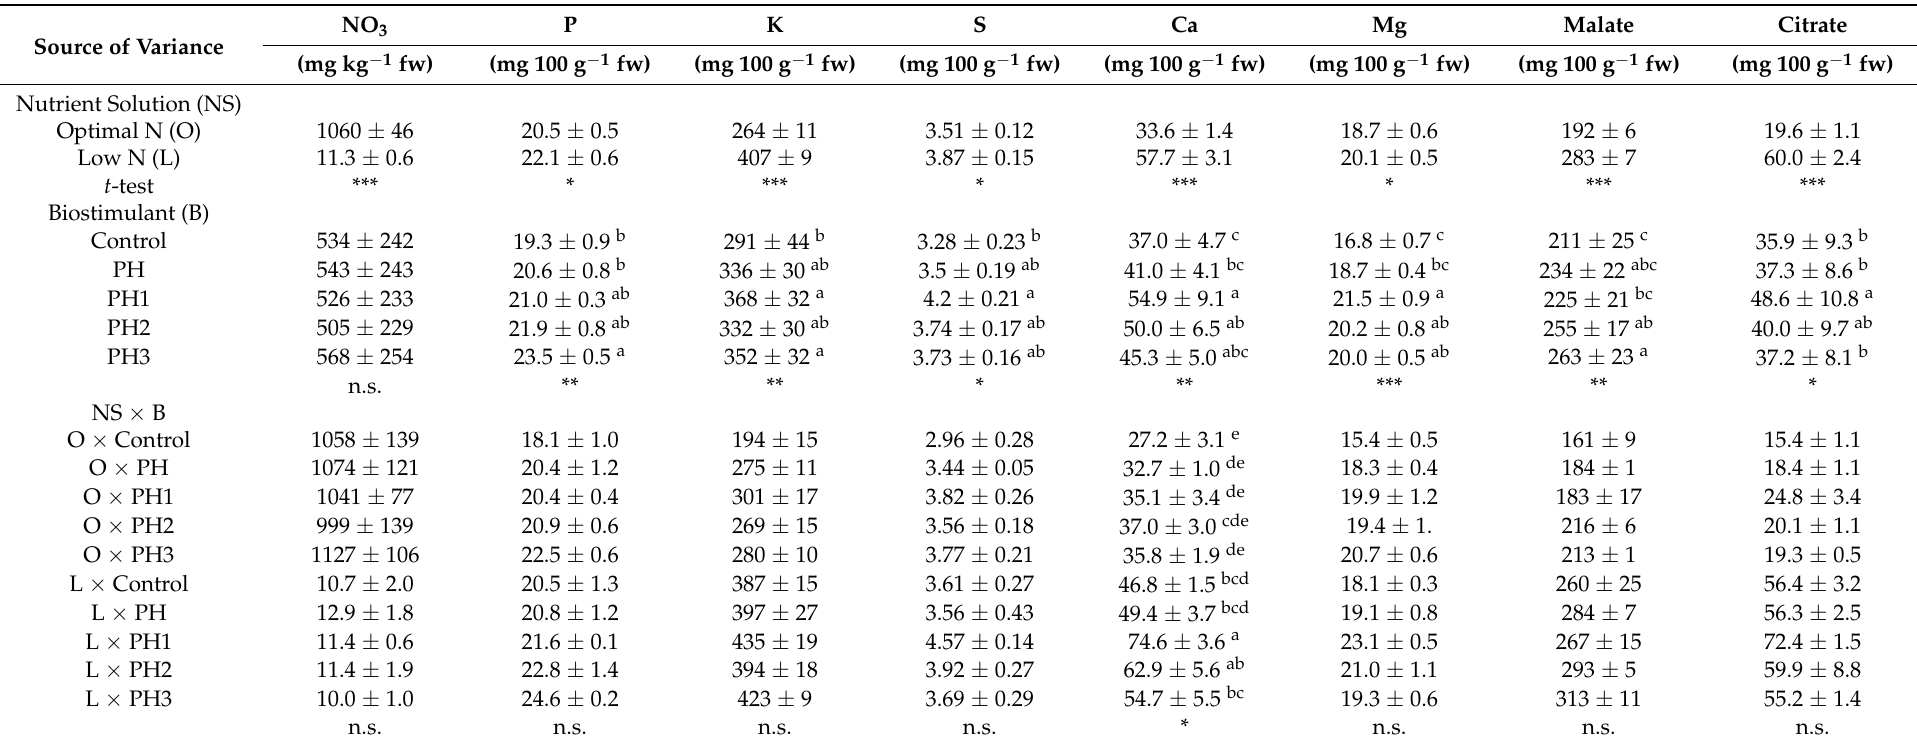
Table 1. Mineral and organic acids analysis of lettuce plants as affected by nitrogen dosage and biostimulant